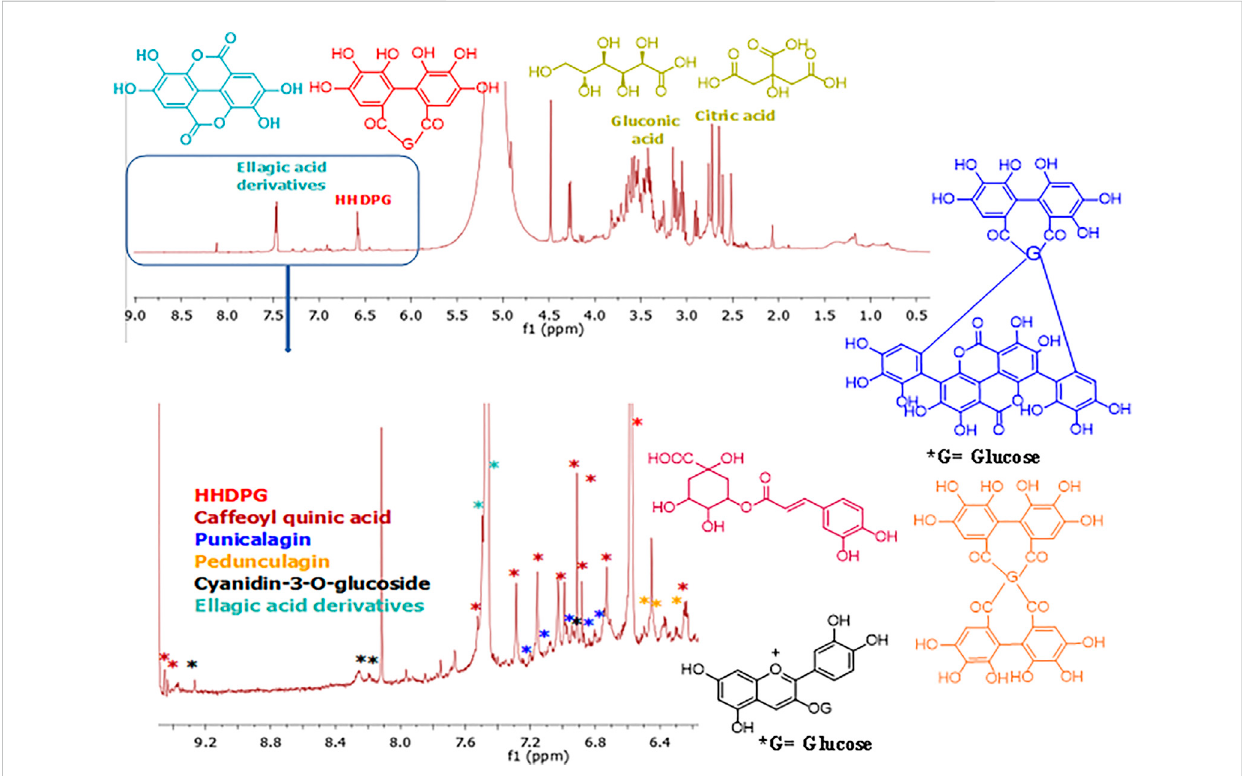
FIGURE 2 1 H NMR fi ngerprint of the pomegranate peel extract PPE (Top) and expanded aromatic protons region (6.30 – 9.50 ppm) (bottom). The structures of the detected compounds are shown. Red: HHDPG, dark red: caffeoyl quinic acid, dark blue: punicalagin, orange: pedunculagin, black: cyanidin-3-O- glucoside, light blue: ellagic acid